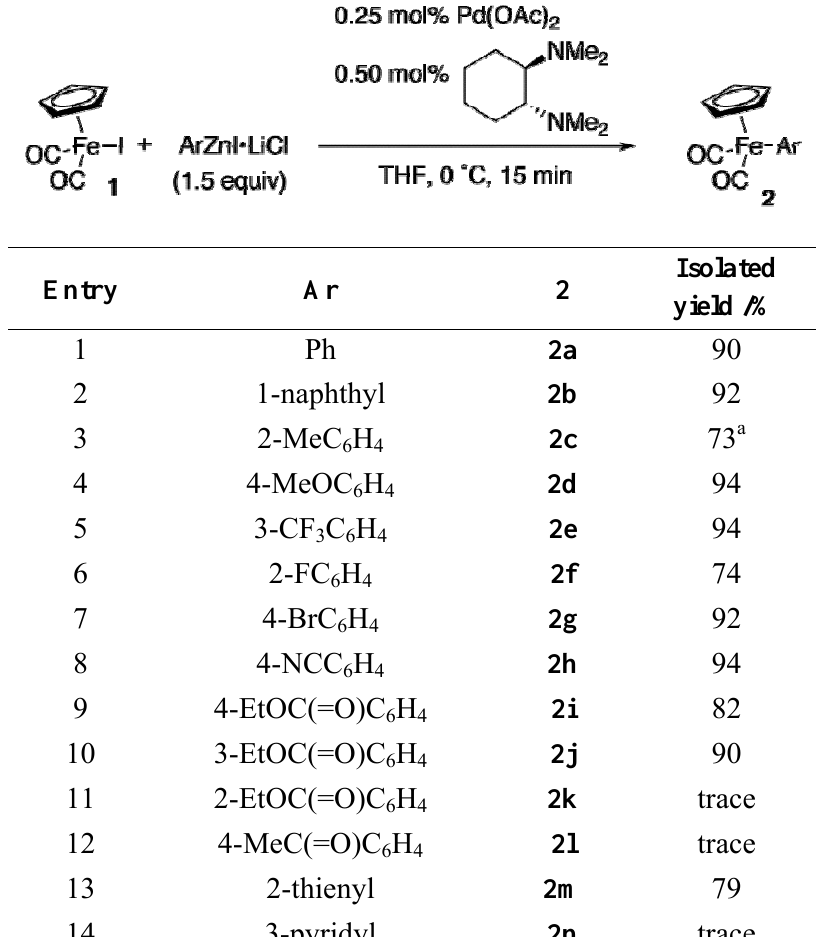
I] with Arylzinc Reagents 2